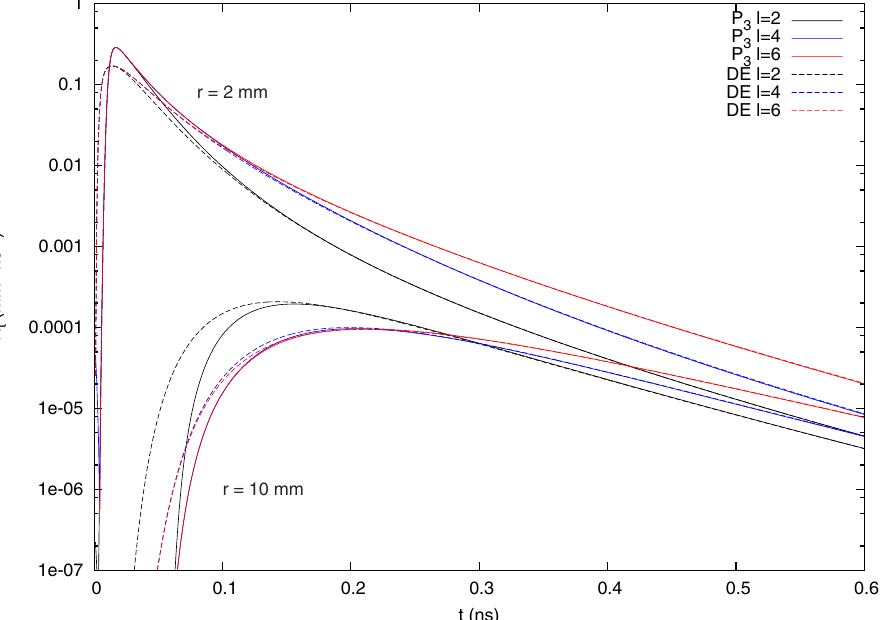
Figure 3. Comparison of time-resolved reflectance results produced by the P 3 approximation and diffusion theory for different upper layer thicknesses of the two-layered model with two source-detector distances r .